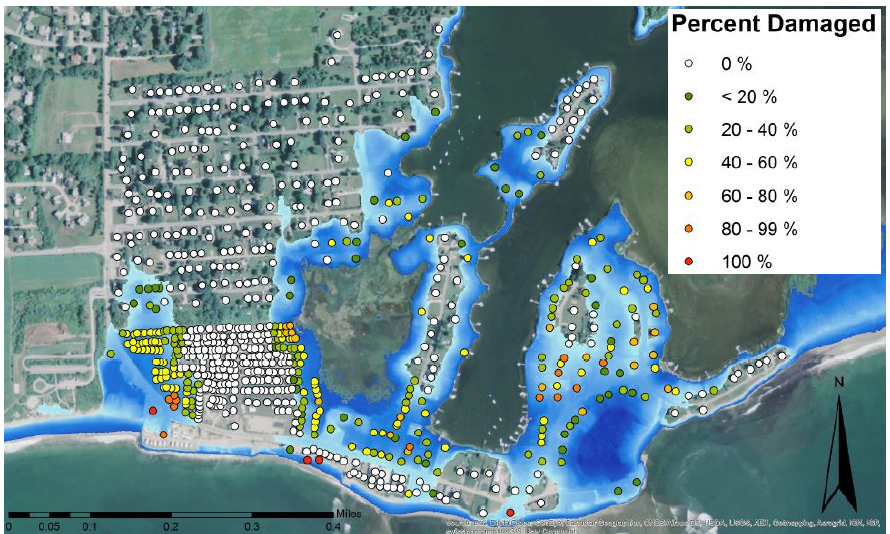
Figure 14. Total estimated damage to each structure from a 100 year storm event with no sea level rise. The extent of inundation is also shown.